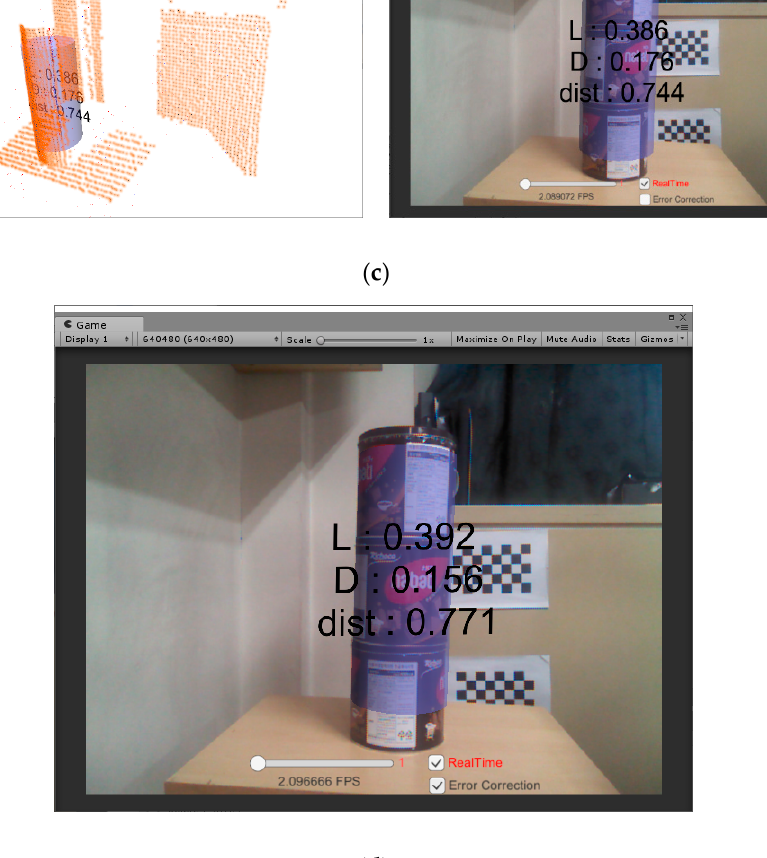
Figure 13. Single frame center axis estimation: ( a ) default unit; ( b ) virtual cylinder using three default units; ( c ) cylinder matching result; ( d ) error correction using the diameter. ( c , d is in meters).